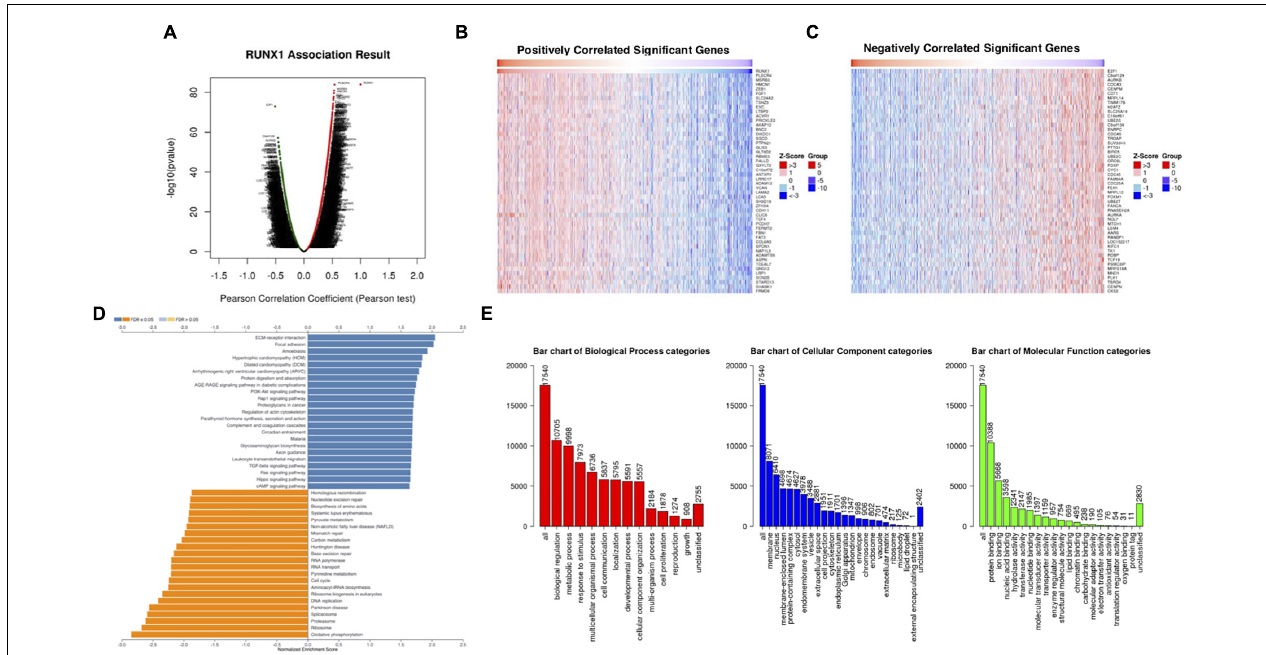
FIGURE 6 | Analysis of differentially expressed genes in correlation with RUNX1 in breast cancer. (A) Volcano plot showing the up-regulated and down-regulated genes correlated with RUNX1 expression (Pearson test). The significantly positively correlated (B) and negatively correlated (C) genes were shown in heatmaps. (D) Kyoto Encyclopedia Genes and Genomes (KEGG) pathway analysis of the significantly differentially expressed genes in correlation with RUNX1. (E) Gene ontology (GO) analysis of the significantly differentially expressed genes in correlation with RUNX1.